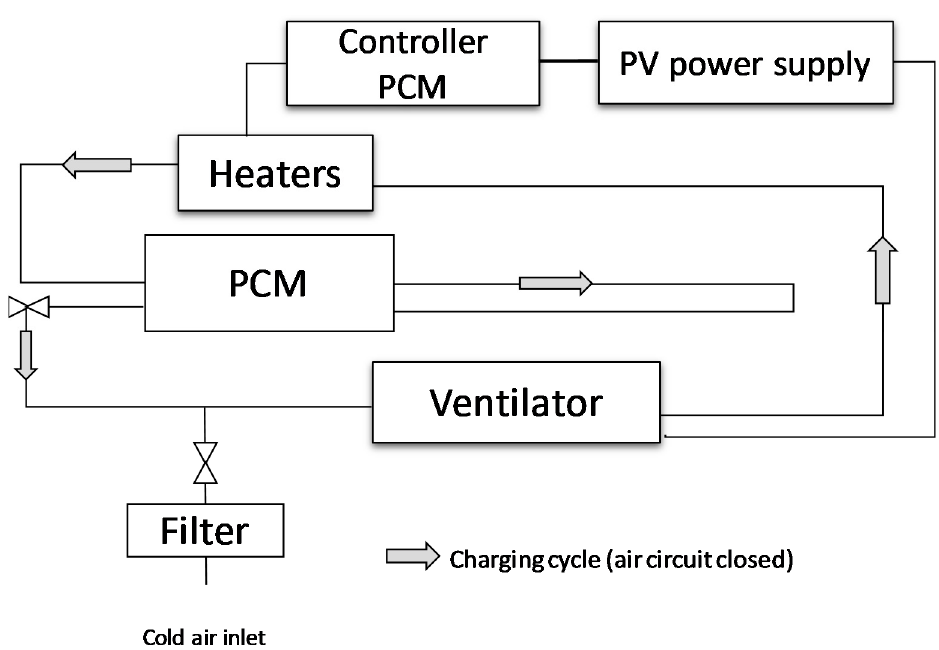
Figure 2. PCM battery charging diagram in a closed circuit.